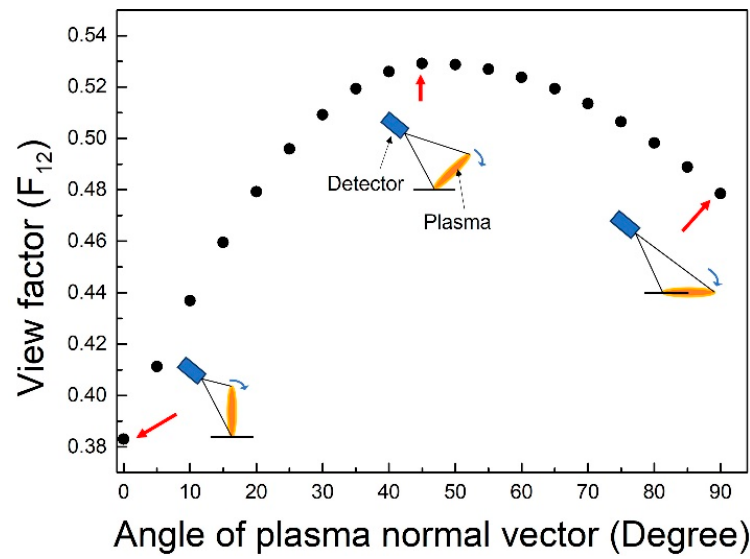
Figure 8. View factor according to the change of the zenith angle.